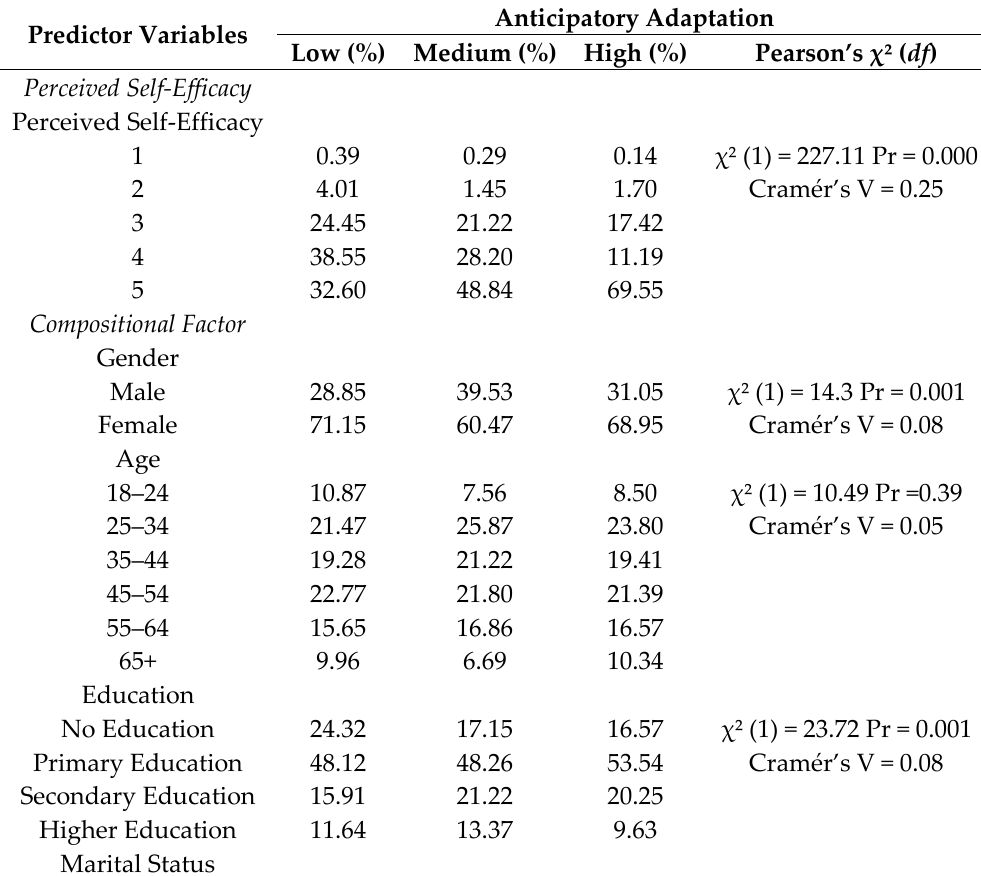
Table 1. Descriptive Statistics of Anticipatory Adaptation to Climate Change reported by individuals in Coastal Cambodia ( n =